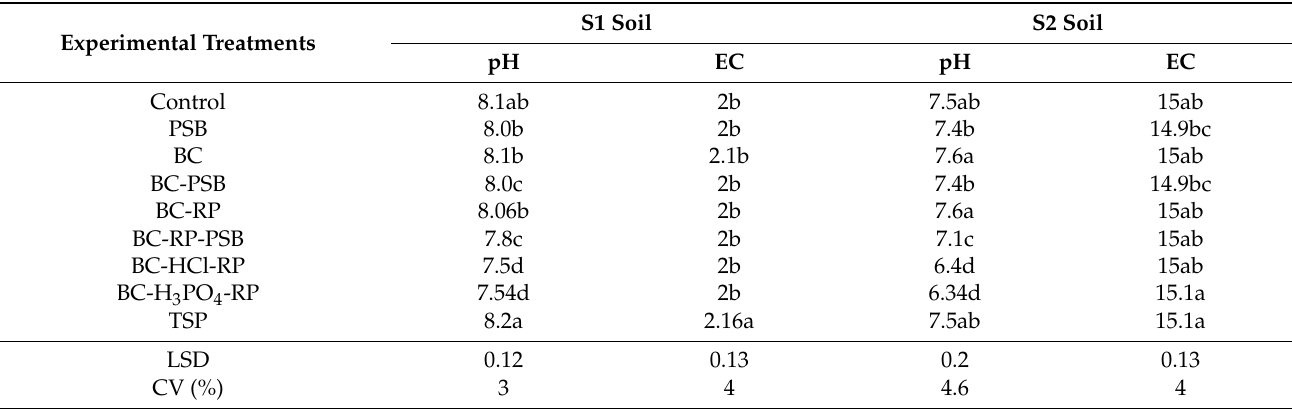
Figure 2. Mean comparison of Olsen- p values for different soil treatments. PSB: phosphate solubilizing bacteria, BC: biochar, BC-PSB: biochar with phosphate solubilizing bacteria, BC-PSB-RP: biochar enriched with PSB and RP, BC-HCl-PSB: biochar enriched with HCl -RP, BC-H 3 PO 4 -RP: biochar enriched with H 3 PO 4 -RP, TSP: triple super phosphate, Cont: control. Means with similar letters are not significantly different at 1% probability level according to LSD test. Error bars are standard deviation of the means ( n = 3), S1 and S2: soil 1 with EC = 2 dS.m − 1 and soil 2 with EC = 15 dS.m − 1 , respectively. Table 7. Effect of treatments on soil pH during the